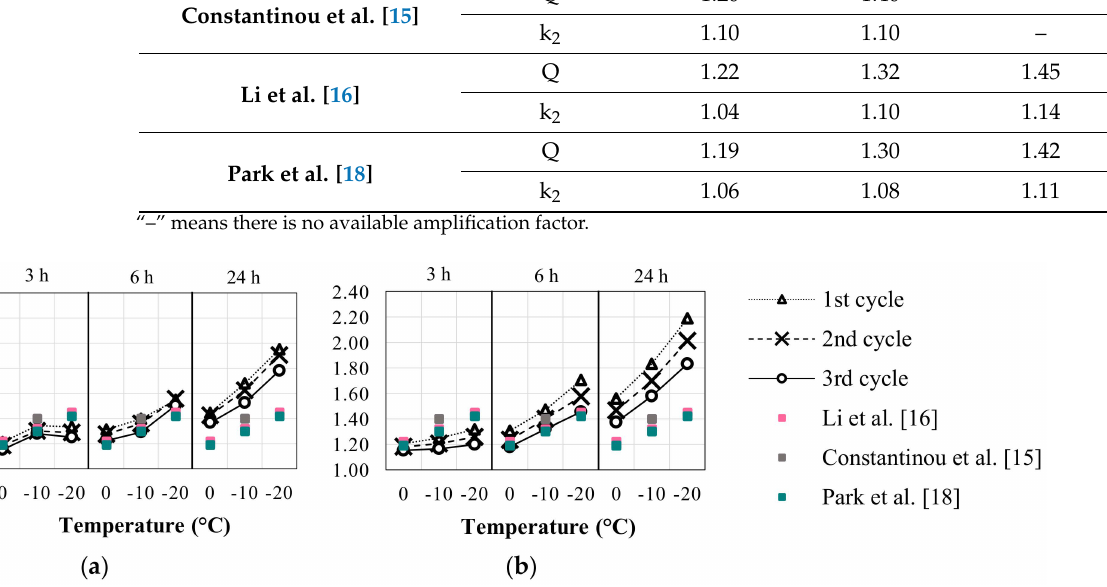
Figure 15. Comparison of amplifications in Q with the available amplification factors in the literature for 0.1 Hz loading frequency at ( a ) 100% and ( b ) 134% shear strains.